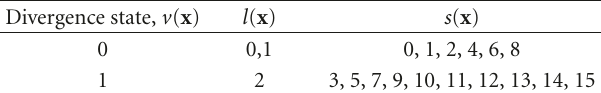
Table 2: The divergence state model for the probabilistic frame-